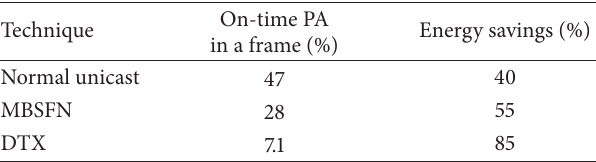
Table 2: Energy savings and on-time PA for different time domain